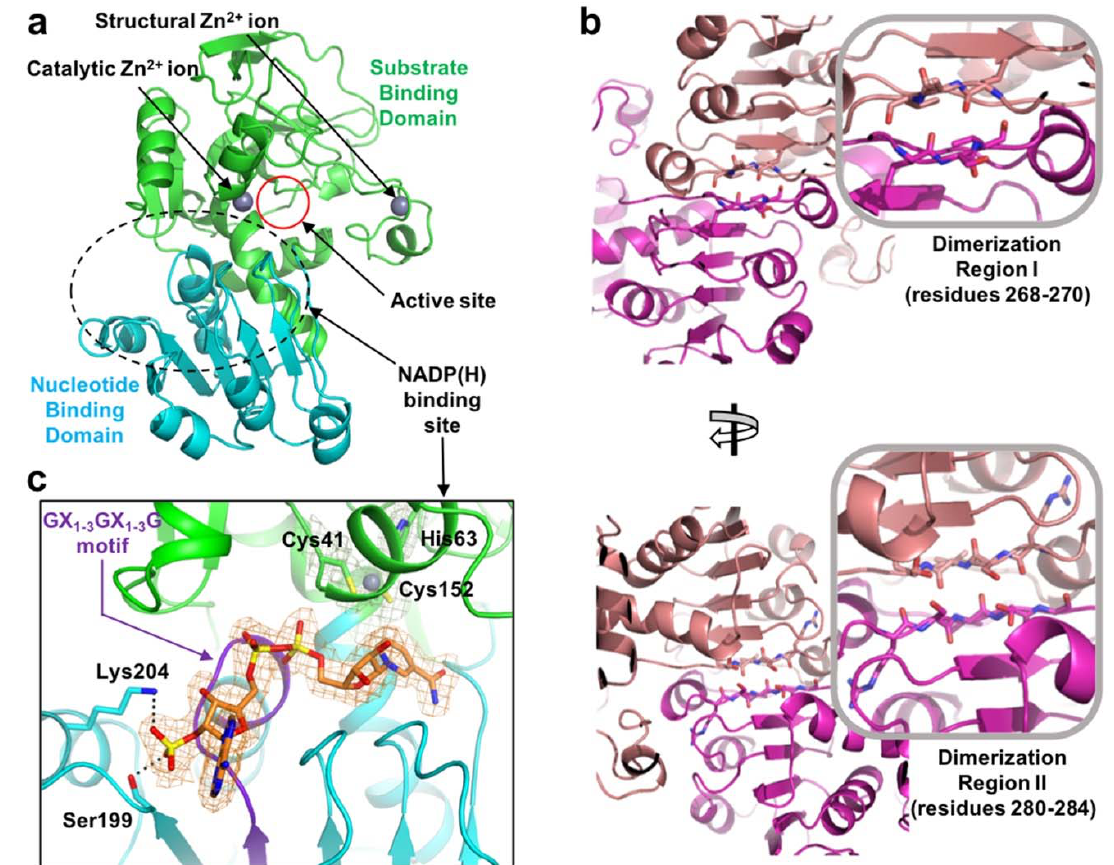
Figure 2. Structure of Escherichia coli YjgB ( Ec YjgB). ( a ) Overall structure. ( b ) Dimeric interface of Ec YjgB. In the outcome of the Proteins, Interfaces, Structures, and Assemblies (PISA) analysis, the dimeric chains are colored as salmon and purple [19] ( c ) NADP binding site. The SBD (substrate-binding domain) and NBD (nucleotide-binding domain) are represented as green and cyan, respectively. The 2Fo-Fc electron densities of NADP (orange), and zinc ion (grey) with its coordinated residues (green) are shown at the 1.0 σ contoured level with their corresponded colors. The GX 1–3 GX 1–3 G motif is indicated as a purple cartoon.